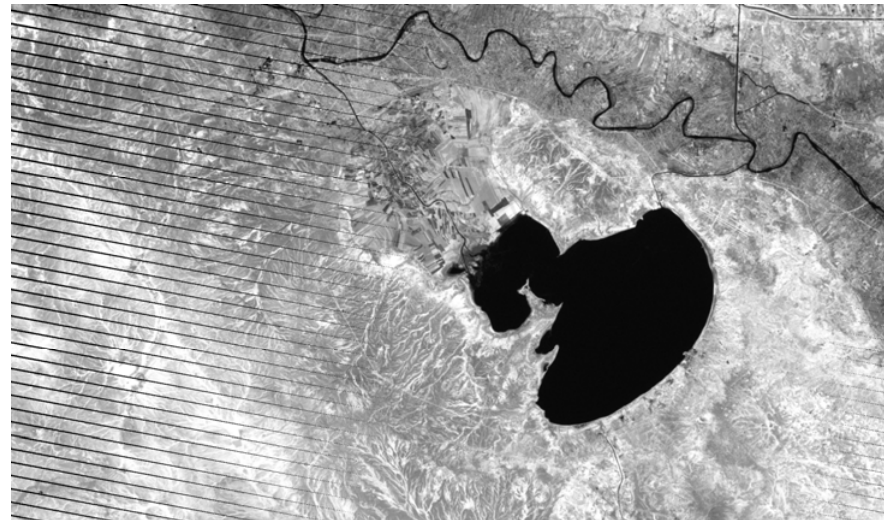
Fig.4: This format illustrates the focal analysis process when executed